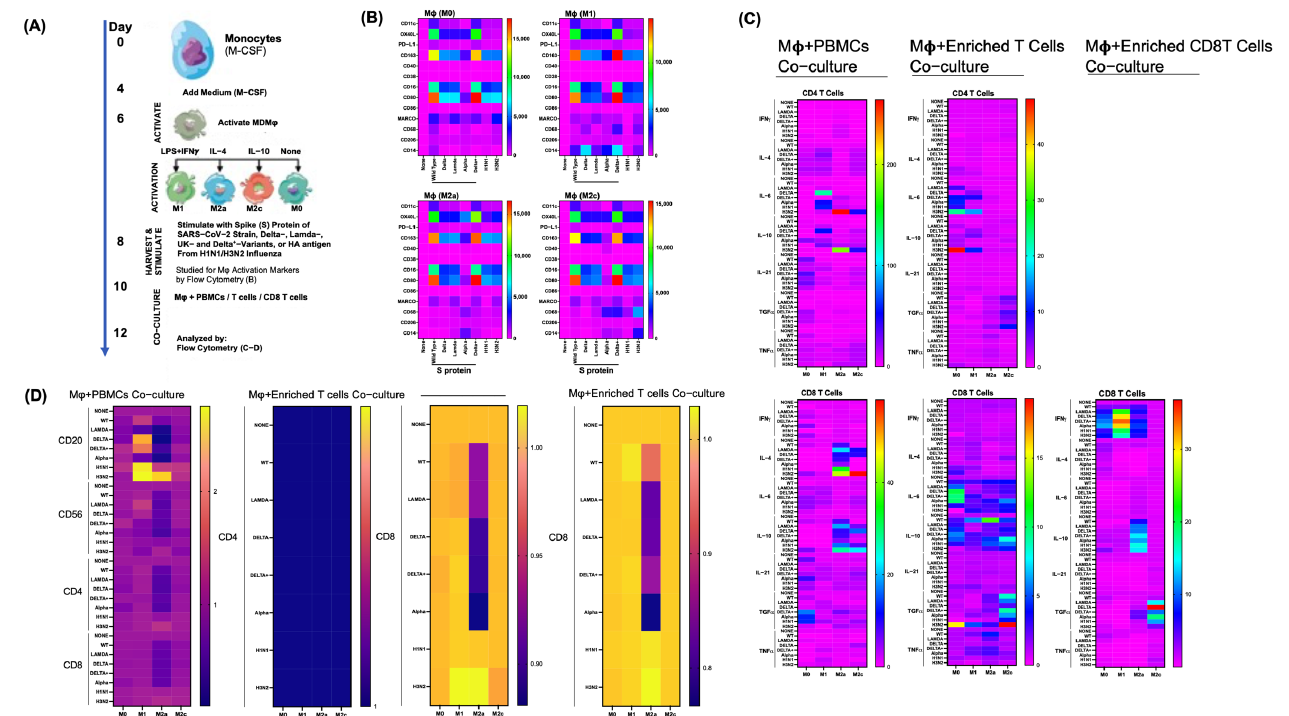
Figure 6. The trimer S protein of SARS-CoV-2 variant-stimulated macrophages in vitro induce T-cell inflammatory responses, and B-cell and CD8 T-cell proliferation in distinct co-cultures. ( A ) The schematic diagram represents an in vitro model of human macrophage (M φ ) cell co-culture and stimulation conditions. ( B ) The heatmap demonstrates the fold-change of co-stimulatory surface molecules expressed on polarized human M φ (N = 8) in the presence of the trimer S proteins of SARS-CoV-2 variants and haemagglutinin/HA antigen protein from H1N1/H3N2 influenza A normalized to none (unstimulated) conditions of distinct M φ . ( C ) The heatmap demonstrates the fold-change of cytokines under stimulated conditions, the trimer S proteins of SARS-CoV-2 variants, and haemagglutinin/HA antigen protein from H1N1/H3N2 influenza A normalized to none (unstimulated) conditions of distinct M φ with respective cytokine conditions. ( D ) The proliferation of lymphocyte subsets is represented by the heatmap of the fold-change normalized to the unstimulated conditions in the presence of distinct M φ cell co-cultures with and without stimulations of the trimer S proteins of SARS-CoV-2 variants, and haemagglutinin/HA antigen protein from H1N1/H3N2 influenza A. Data in each experiment condition represents a co-culture of eight individual donors (M